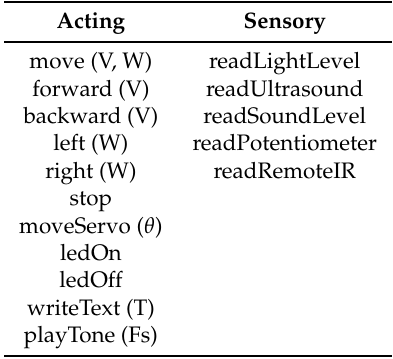
Table 1. PyBoKids.py programming